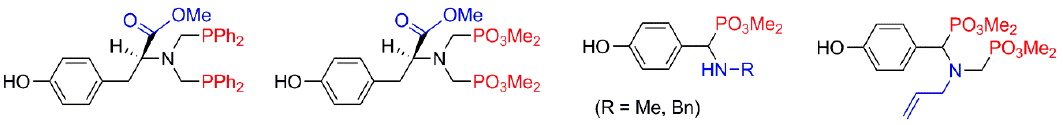
Figure 18. Results of the addition of dimethylphosphonate on terminal aldehydes ( left ) or imines ( right ). 5. Conclusions Phosphorus-containing dendrimers constitute a special class of dendrimers, which possess advantageous properties related to the versatility of their synthesis and the multiple possibilities and modularity of their functionalization. One important property is the large variety of possibilities offered by these dendrimers to elaborate bifunctional structures, that is to say dendritic structures possessing two (or more) types of functional groups. Indeed, these dendrimers offer the possibility to have functional groups at the core (or close to it), within the branches, but also two types of precisely organized terminal functions. Thanks to these special features, phosphorus-containing dendrimers have already been used as reusable and efficient catalysts, for the elaboration of nanomaterials, as fluorescent agents for bio-imaging, and as drugs by themselves, to name as a few uses. All these properties pave the way for the search of other properties, which will surely benefit from the tools already elaborated for having two types of functional groups, in precise positions of dendritic structures. Acknowledgments: The Centre National de la Recherche Scientifique (CNRS) and the COST action CM1302 SIPs are acknowledged for financial support. Author Contributions: A.M.C wrote the paper, J.P.M read it and gave useful comments. Conflicts of Interest: The authors declare no conflict of interest.